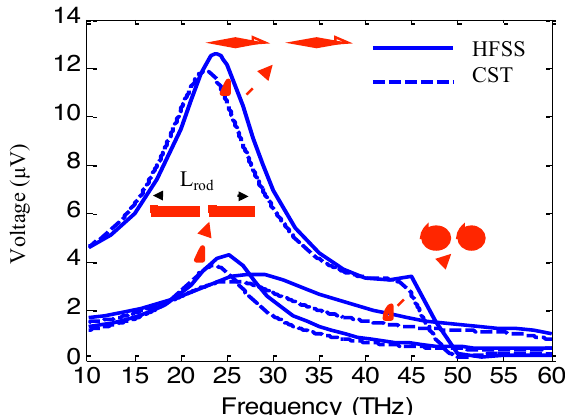
Figure 7. The voltage variation verses frequency for different dipole shapes.